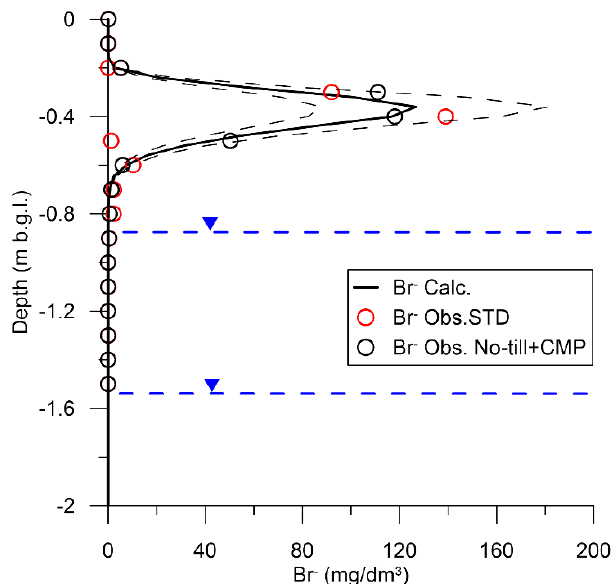
Figure 5. Comparison of the calculated (black line) and observed (open circles) Br − concentrations profiles collected on 27 March 2018 in both the experimental plots. Calculated Br − concentrations using a Cr max of ±15% (dashed black lines) and minimum and maximum groundwater heads (dashed blue lines) are also plotted.